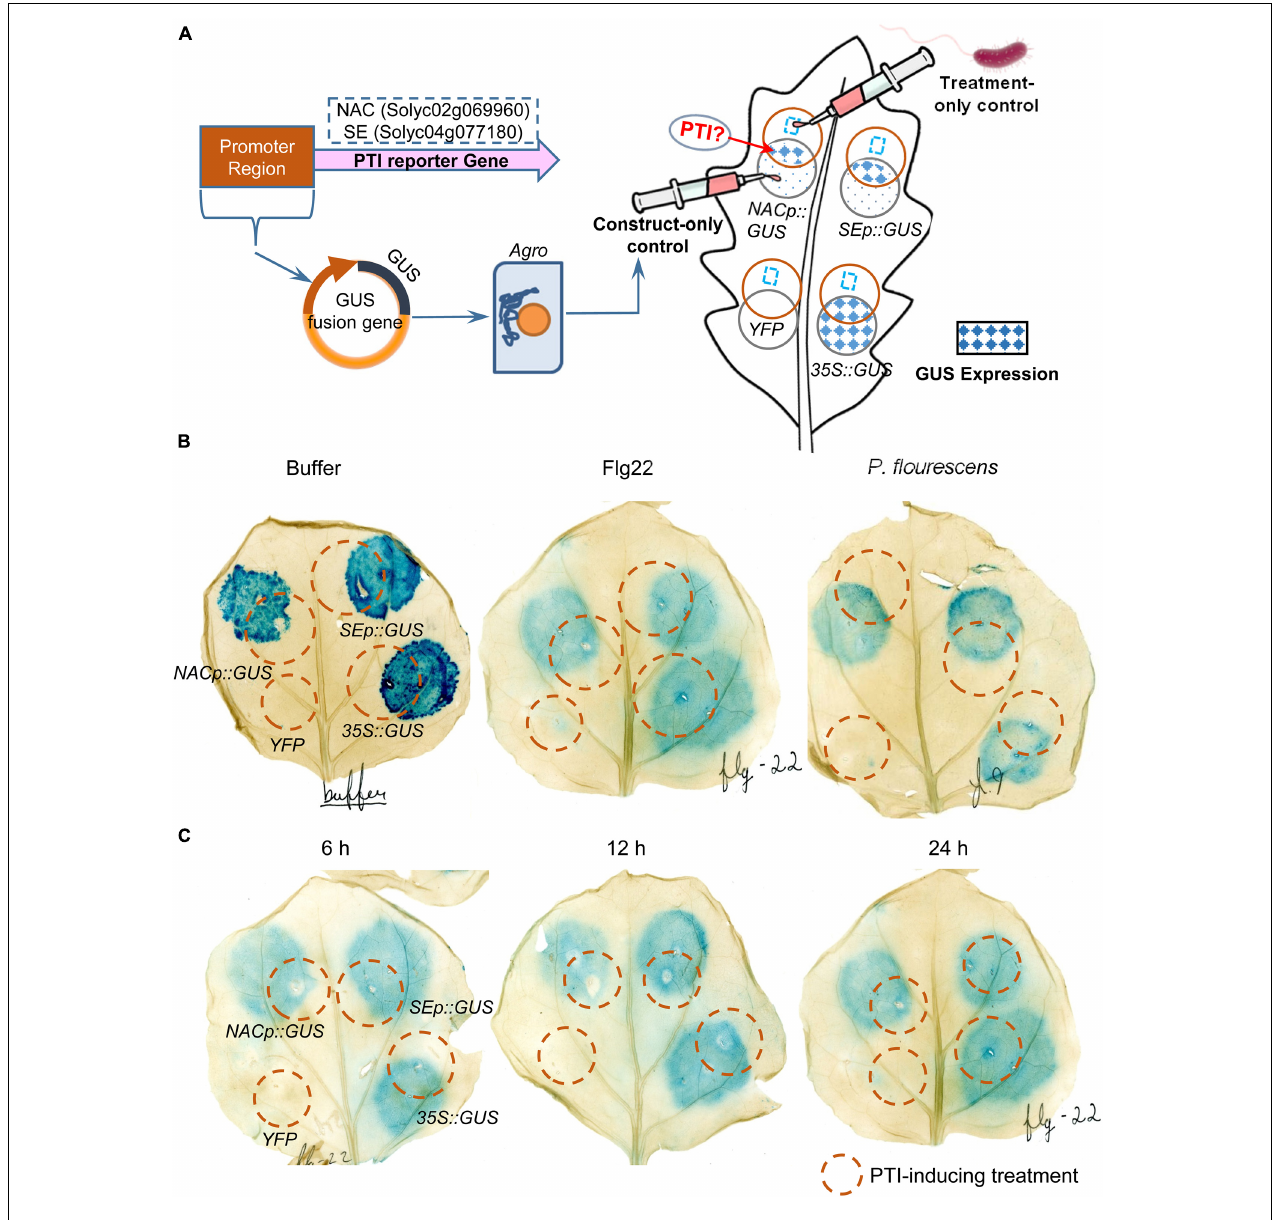
FIGURE 6 | Transient expression assays of NAC and SE genes in N. benthamiana leaves in response to different PTI-inducing treatments at different time-points. (A) Schematic workflow of the assay and interpretation of the “overlapping circle” pattern permitted for a qualitative analysis of the GUS histochemical stain. Each leaf was infiltrated with four agrobacterium constructs: YFP (negative control), 35S : GUS (positive control), NACp : GUS and SEp : GUS ; (B) N. benthamiana leaves treated with negative control buffer, flg22, and P. fluorescens for 12 h and then GUS staining for 16 h; and (C) N. benthamiana leaves treated with flg22 for 6, 12, and 24 h and then GUS staining for 16